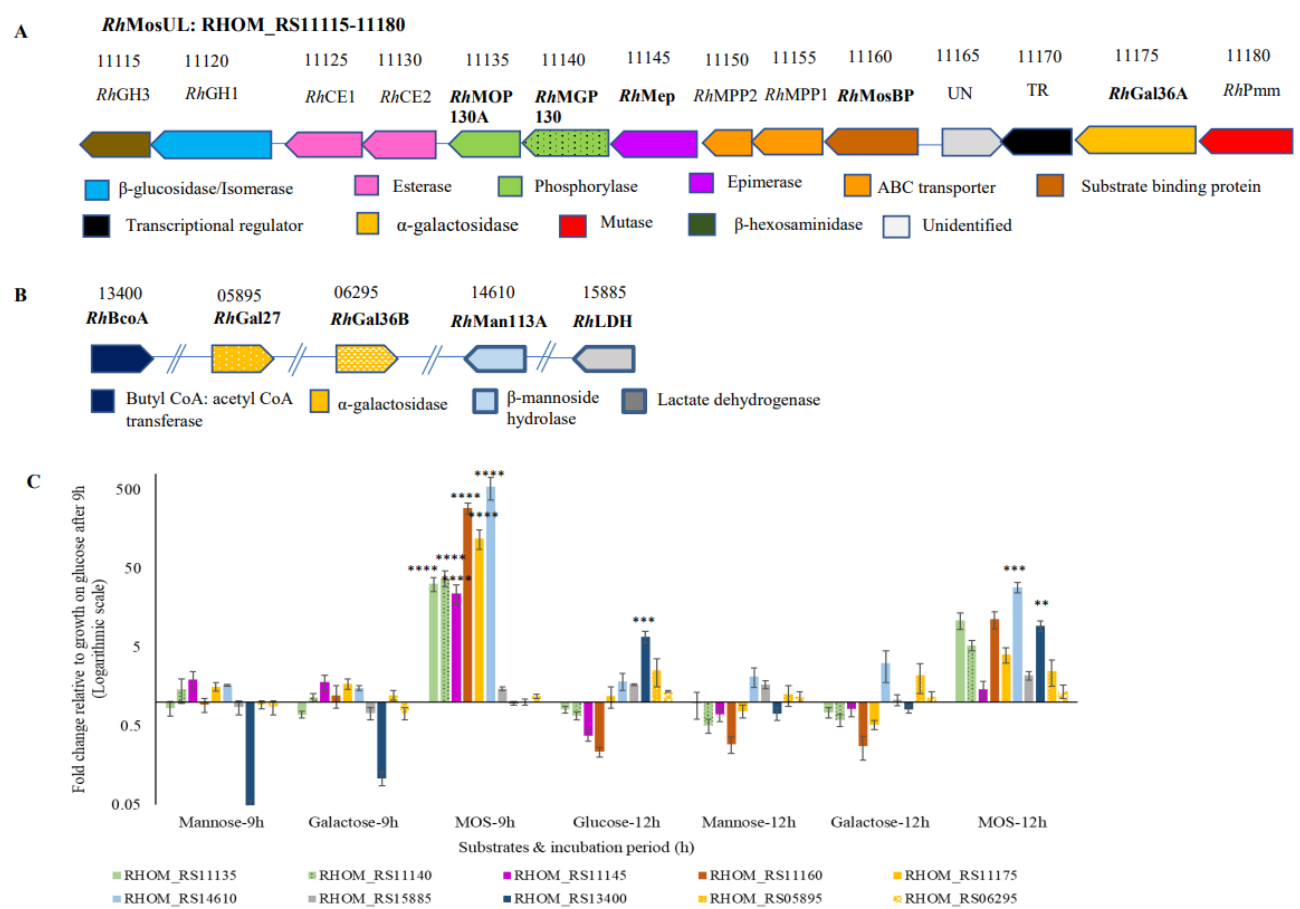
Figure 3. Gene expression analysis, using reverse transcription-quantitative PCR (RT-qPCR) during the growth of R. hominis on different substrates (glucose, mannose, galactose, and (galacto)- β -mannan-oligosaccharide, MOS/GMOS). ( A ) A putative MOS/GMOS utilization locus ( Rh MosUL, RHOM_RS11115-11180) is predicted to be involved in MOS/GMOS utilization. ( B ) Other selected putative genes distributed across the genome were predicted to potentially be involved in MOS/GMOS utilization and short-chain fatty acid (SCFA) production. ( C ) Relative expression of 10 target genes expressed as fold change (logarithmic) relative to growth on glucose after 9 h. The putative function of the target genes RHOM_RS11135, RHOM_RS11140, RHOM_RS11145, RHOM_RS11160, RHOM_RS11175, RHOM_RS14610, RHOM_RS15885, RHOM_RS06425, and RHOM_RS13400 was functionally predicted as β -mannoside phosphorylase ( Rh MOP130A), mannosylglucose phosphory- lase ( Rh MGP130), epimerase ( Rh Mep), ABC substrate-binding protein ( Rh MosBP), α -galactosidase ( Rh Gal36A), β -mannoside hydrolase (RhGH113A), lactate dehydrogenase ( Rh LDH), and butyl CoA: acetate CoA transferase ( Rh BCoA). One-way ANOVA with Tukey’s post hoc test was used to deter- mine whether the differential expression of the genes was significant during growth on different substrates over two different time points (9 and 12 h). The significantly different means are shown as ** p < 0.01, *** p < 0.001, and **** p < 0.0001. Data from triplicate cultivations and mean values ± SD (standard deviation) are